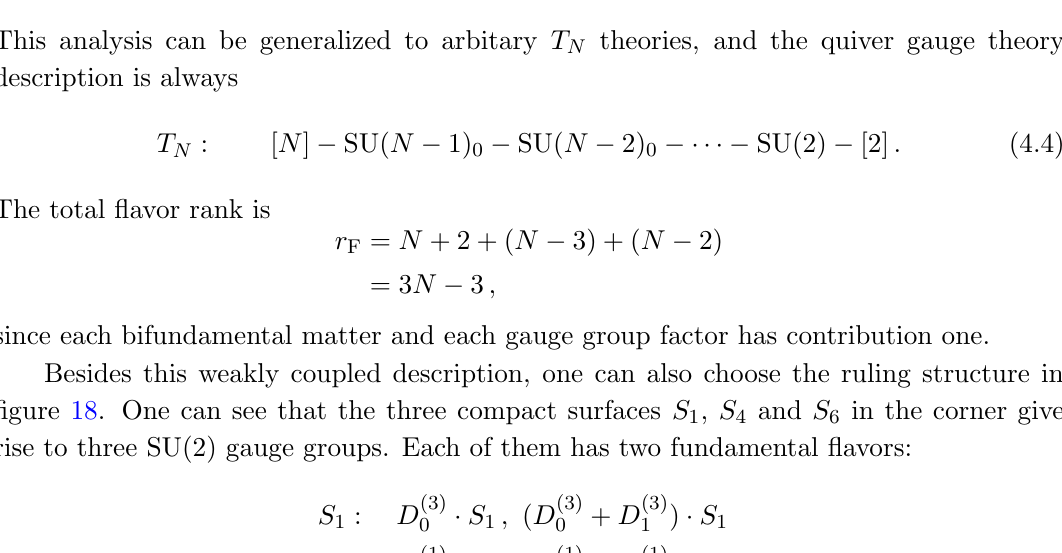
Figure 18 . The ruling structure of compact surfaces in the example of T 5 theory that realizes the SO(4) 3 IR (cid:13)avor symmetry. Each red line denotes the section curve of the ruling. The quiver description is not weakly